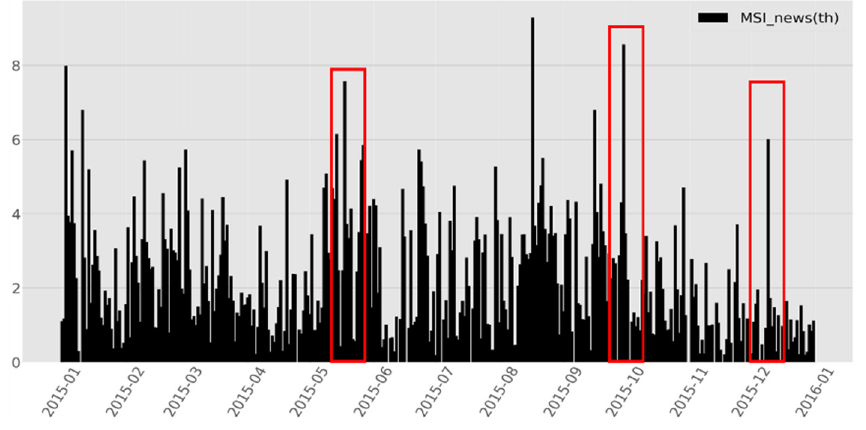
Figure 5. Keywords related to threat‑based results ( MSI_news th